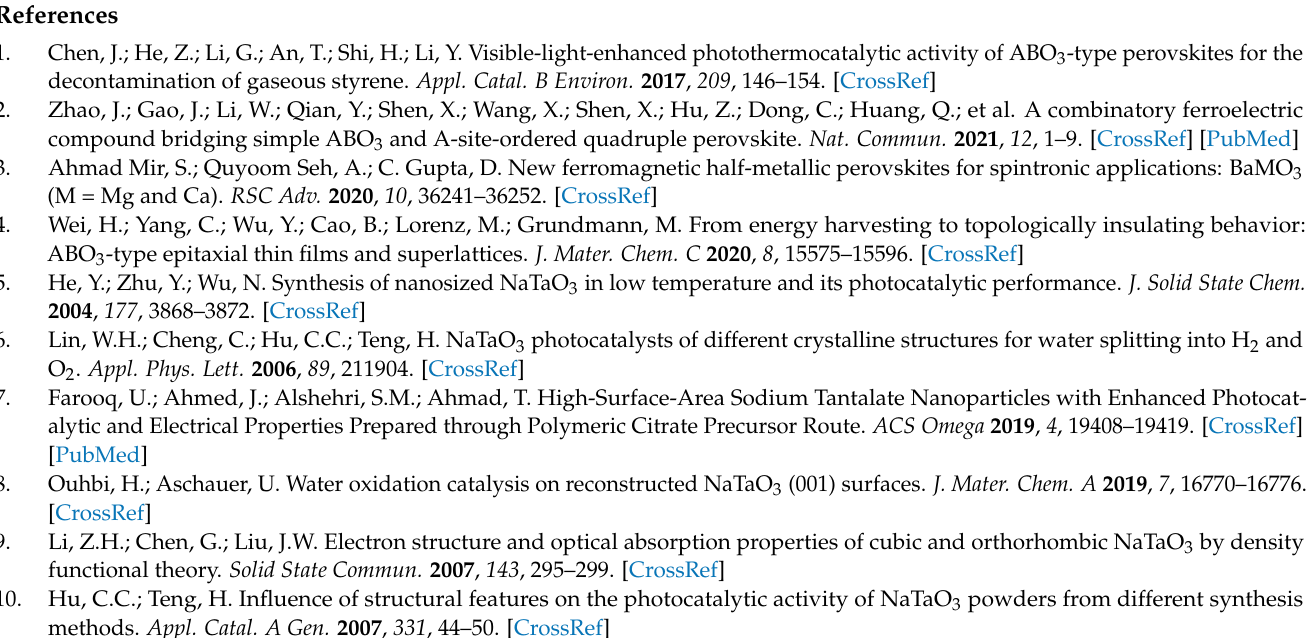
Figure S2: Carbonate amount versus sample position for the batch 1-1; Figure S3: Tauc plots of the samples Na 0.4 TaO 3 − δ and Na 1.2 TaO 3+ δ ; Table S1: Average thickness with the corresponding standard deviation; and Table S2: Stoichiometry, Na/Ta and x of samples deposited in the five deposition